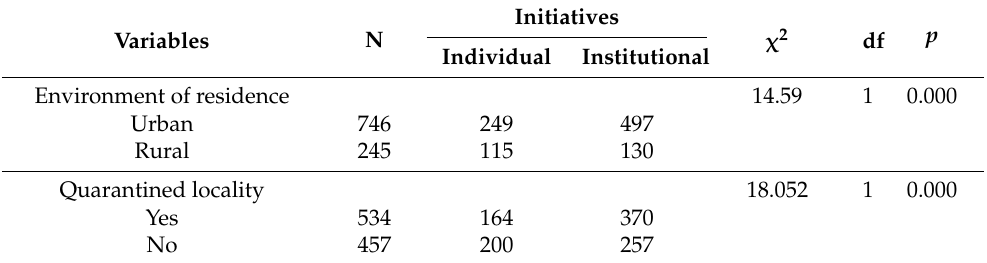
Table 1. NGO initiatives/residence environment and status of